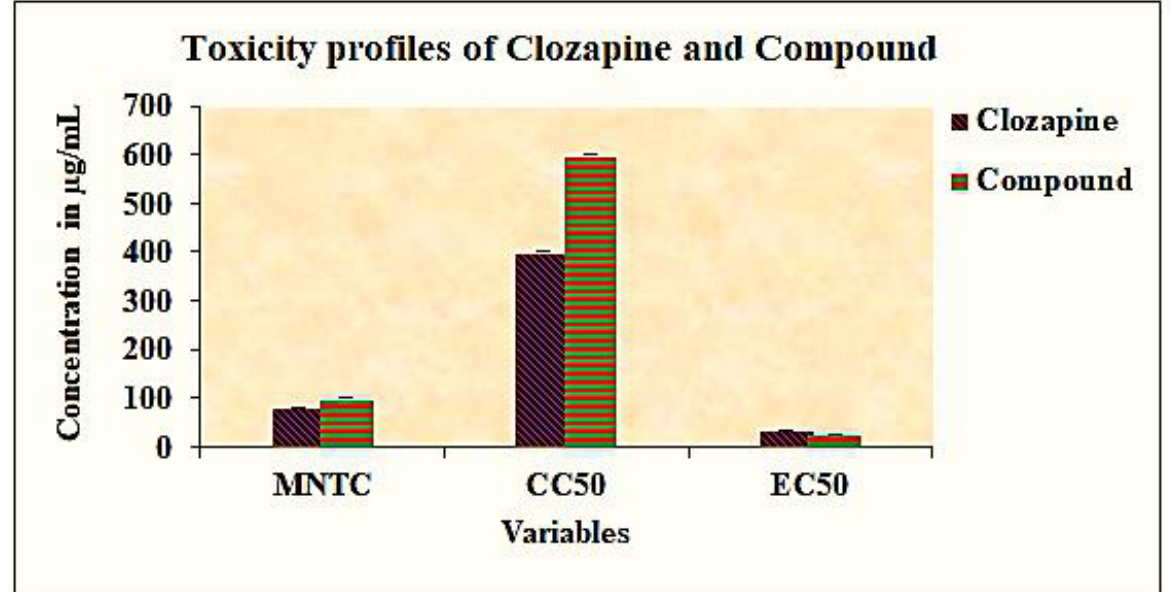
Figure 1. Graphical representation of MNTC, CC50, and EC50 of compound and clozapine.